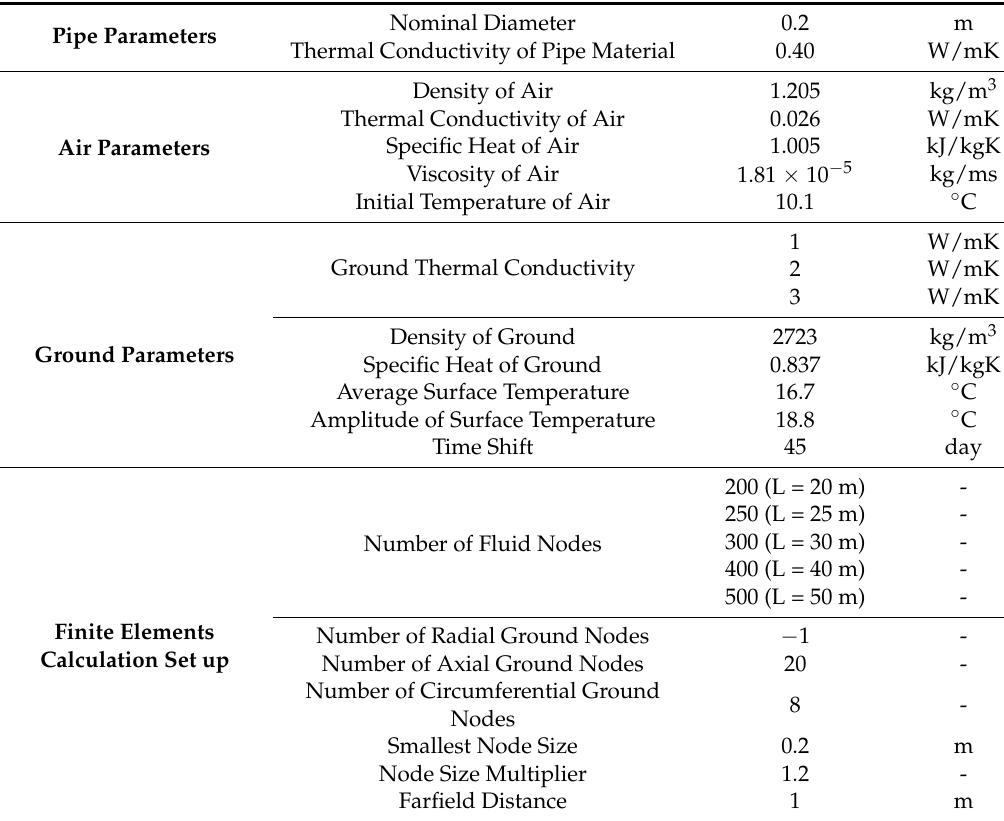
Table 1. Configuration parameters of